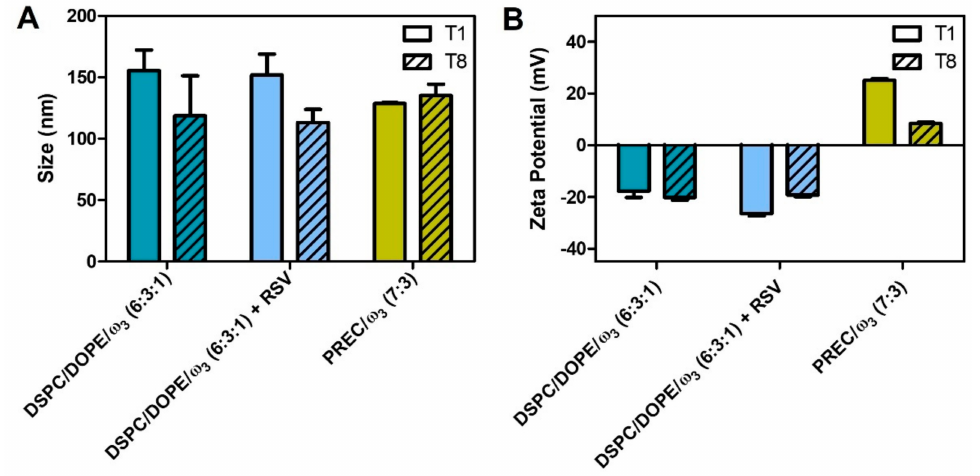
Figure 2. Stability characterization of lipid nanosystems during storage at 4 ◦ C. The data represent the means ± SD of the size ( A ) and surface charge (zeta potential (mV) ( B ) values over 8 weeks. The average size of DSPC/DOPE/ ω 3 (6:3:1) (156 ± 17 nm) was not significantly dif- ferent from that obtained by Skibinski et al. (137 ± 12 nm) [41], which also included a fish oil rich in DHA encapsulated in LUV composed of archaelipids. When com- pared with the LUV obtained by Alaarg et al. (99 ± 16 nm), which constituted ω 3 , 1,2-dipalmitoyl- sn -glycero-3-phosphocholine, cholesterol, and PEG 2000 , our lipid